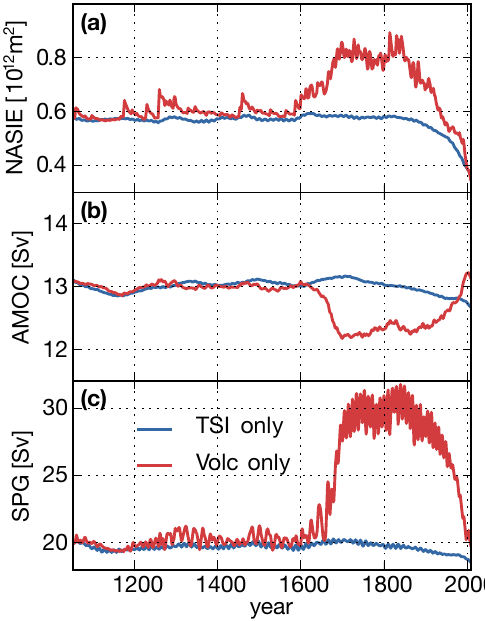
Fig. 4. Last millennium simulations for TSI (blue) and volcanic forcing only (red) without prescribed wind-stress. (a) NASIE, (b) AMOC and (c) SPG. Fig. 3. To identify the driving processes behind SPG and AMOC dy-